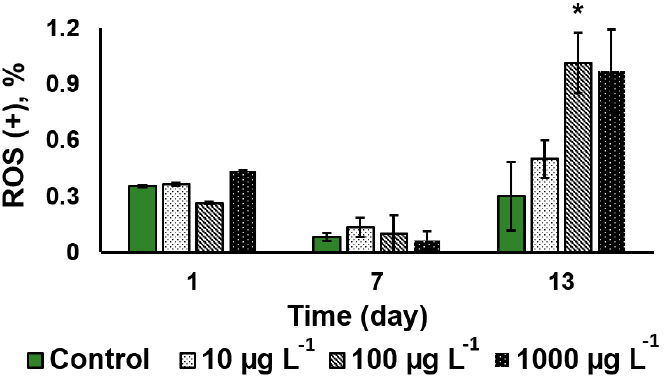
Figure 5. Comparative analysis of the oxidative stress severity in the Desmodesmus sp. cells as a function of the added CuO-NP concentration. (Values significantly differing from the control are marked with an asterisk, *).